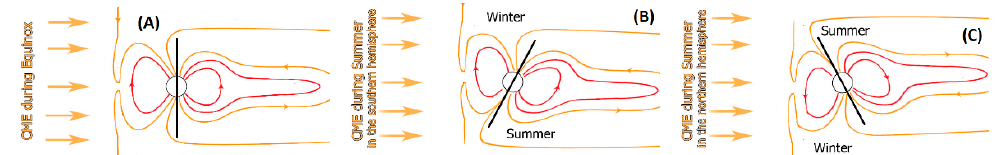
Figure 5. A sketch shows the path of the CME’s plasma, through the magnetosphere, directed into the left panel ( A ): during the equinoxes; the middle panel ( B ): during summer for the southern hemisphere; the right panel ( C ): during summer for the northern hemisphere. The shortest path to the pole is during the summer season, while the longest one is during the winter season.